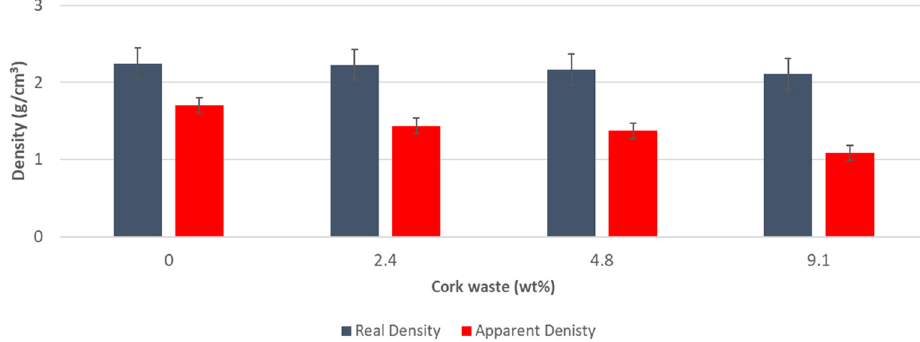
Figure 4. Real density and apparent density of all geopolymers after 28 days.